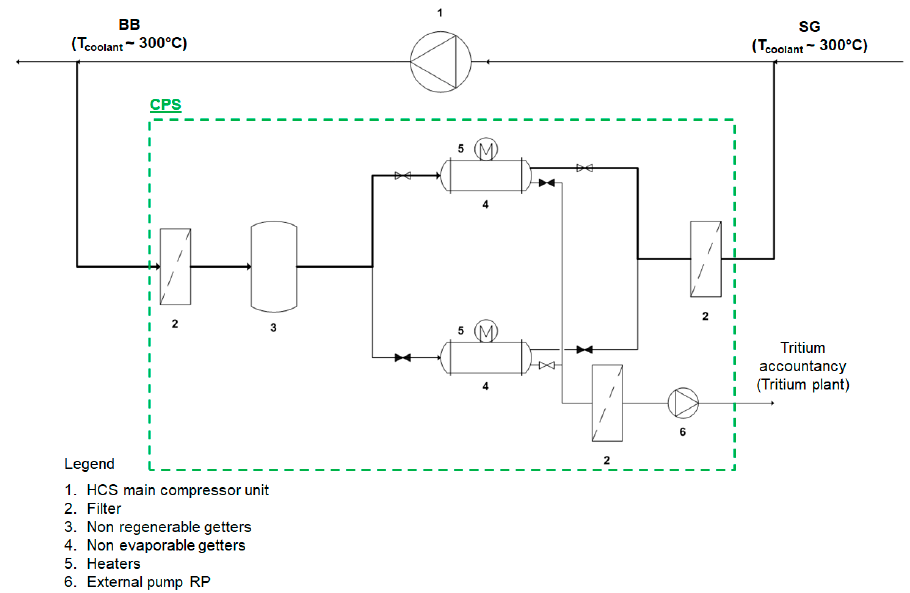
Figure 3. Scheme of the CPS pre-conceptual design based on novel Non-Evaporable Getter material.